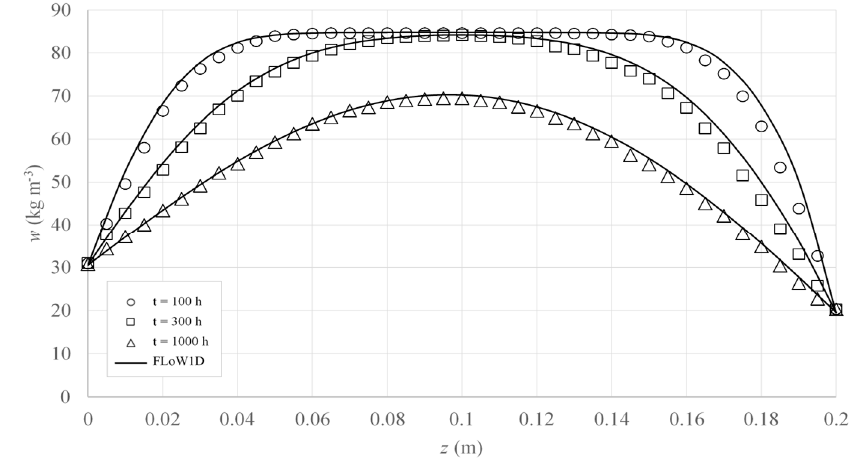
Figure 4. Water content isochrones ( w ) obtained with FLoW1D vs. reference solution (HAMSTAD Benchmark 2). Markers, reference solution; solid lines, FLoW1D results.